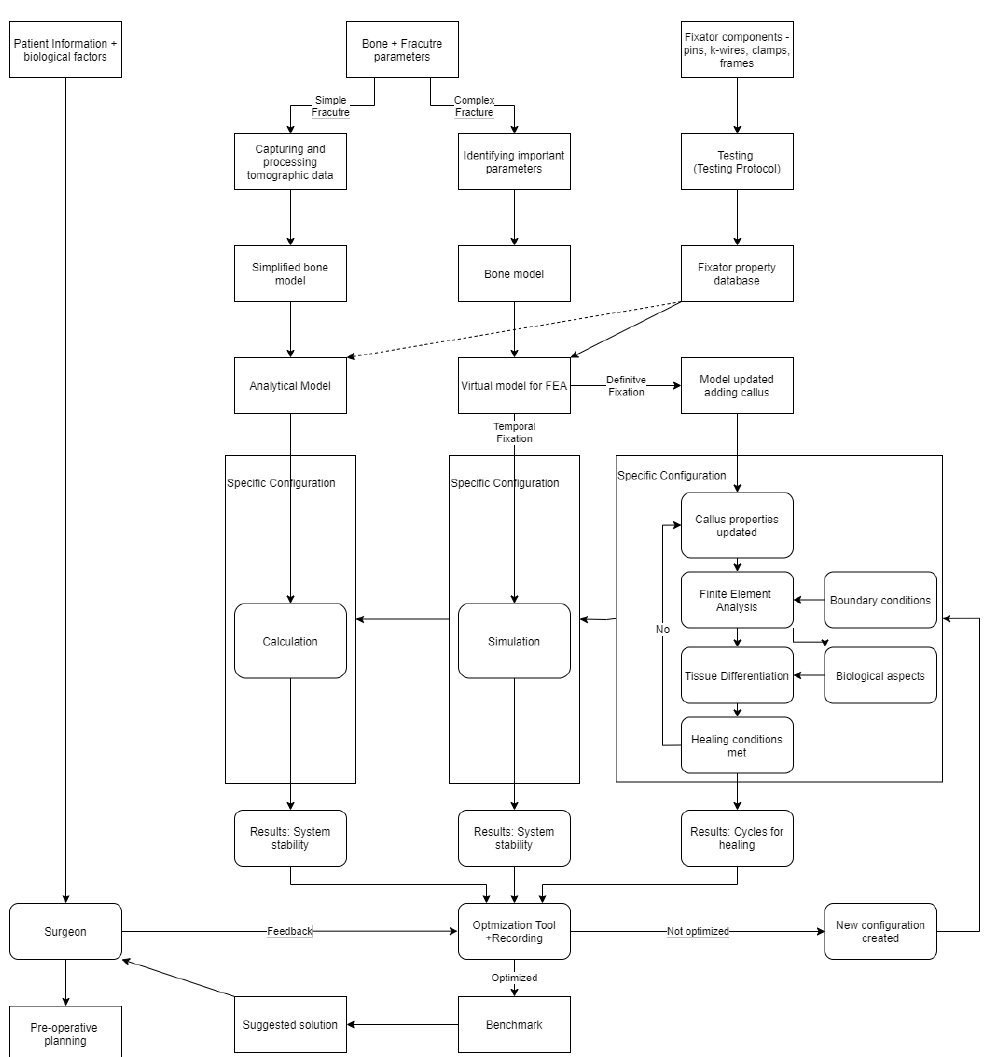
Figure 3. Optimized framework for developing regions, reducing complexity in instances where simplification is